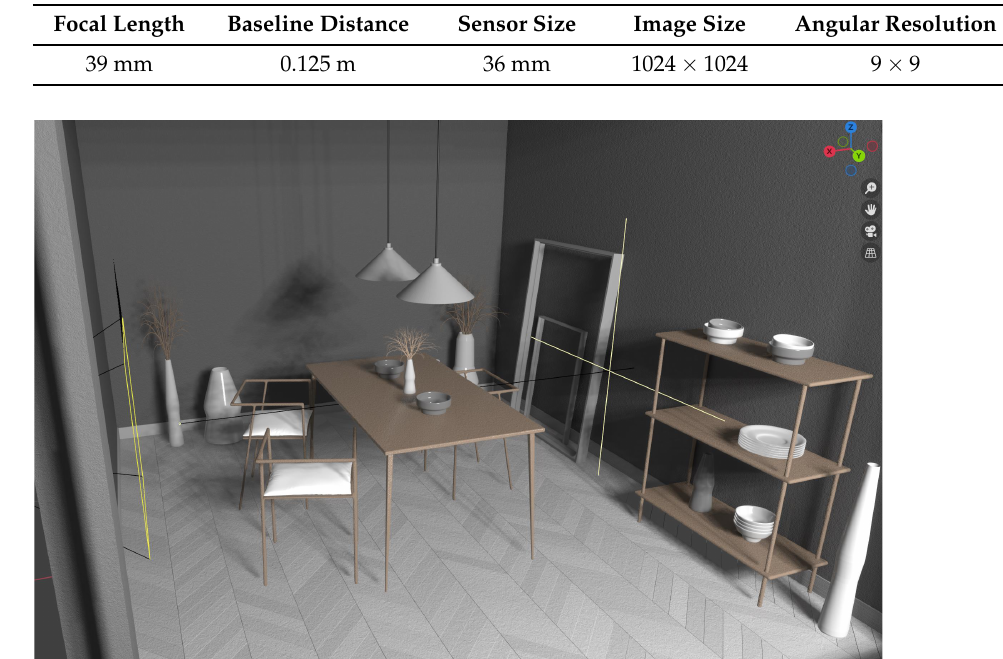
Table 1. Camera parameters set in the Blender platform.